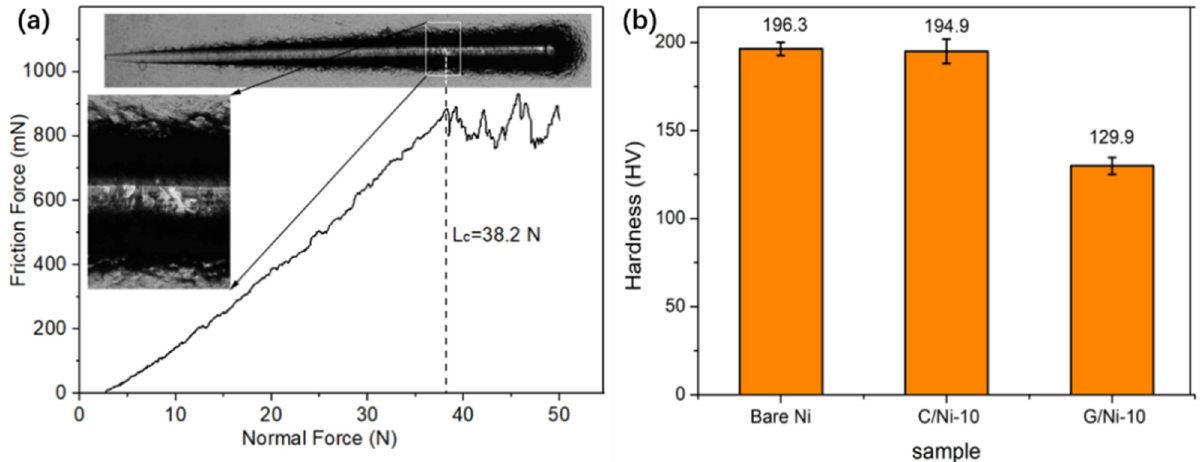
Figure 4. ( a ) Diagram of the scratch test curve of C/Ni-10 with inset optical images of the scratch track ; ( b ) Hardness value of bare Ni, C/Ni-10 and G/Ni-10. track; ( b ) Hardness value of bare Ni, C/Ni-10 and